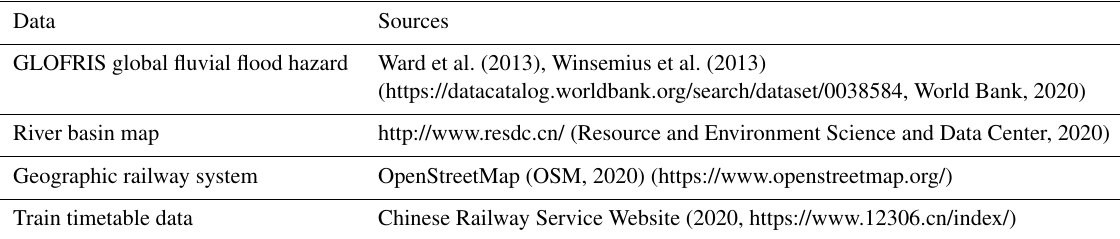
Figure 1. The spatial distribution of the railway network, average daily number of trains, and the main river basin in China. The river basin layer comes from the Data Center for Resources and Environmental Sciences, Chinese Academy of Sciences, accessible from the Resource and Environment Data Cloud Platform (http://www.resdc.cn/, last access: 19 May 2020). Railway geometries © OpenStreetMap contributors 2019. Distributed under the Open Data Commons Open Database License (ODbL) v1.0. The timetable data include the daily number of trains and associated routes from the Railway Service Website (Liu et al., 2018a). Table 1. List of data